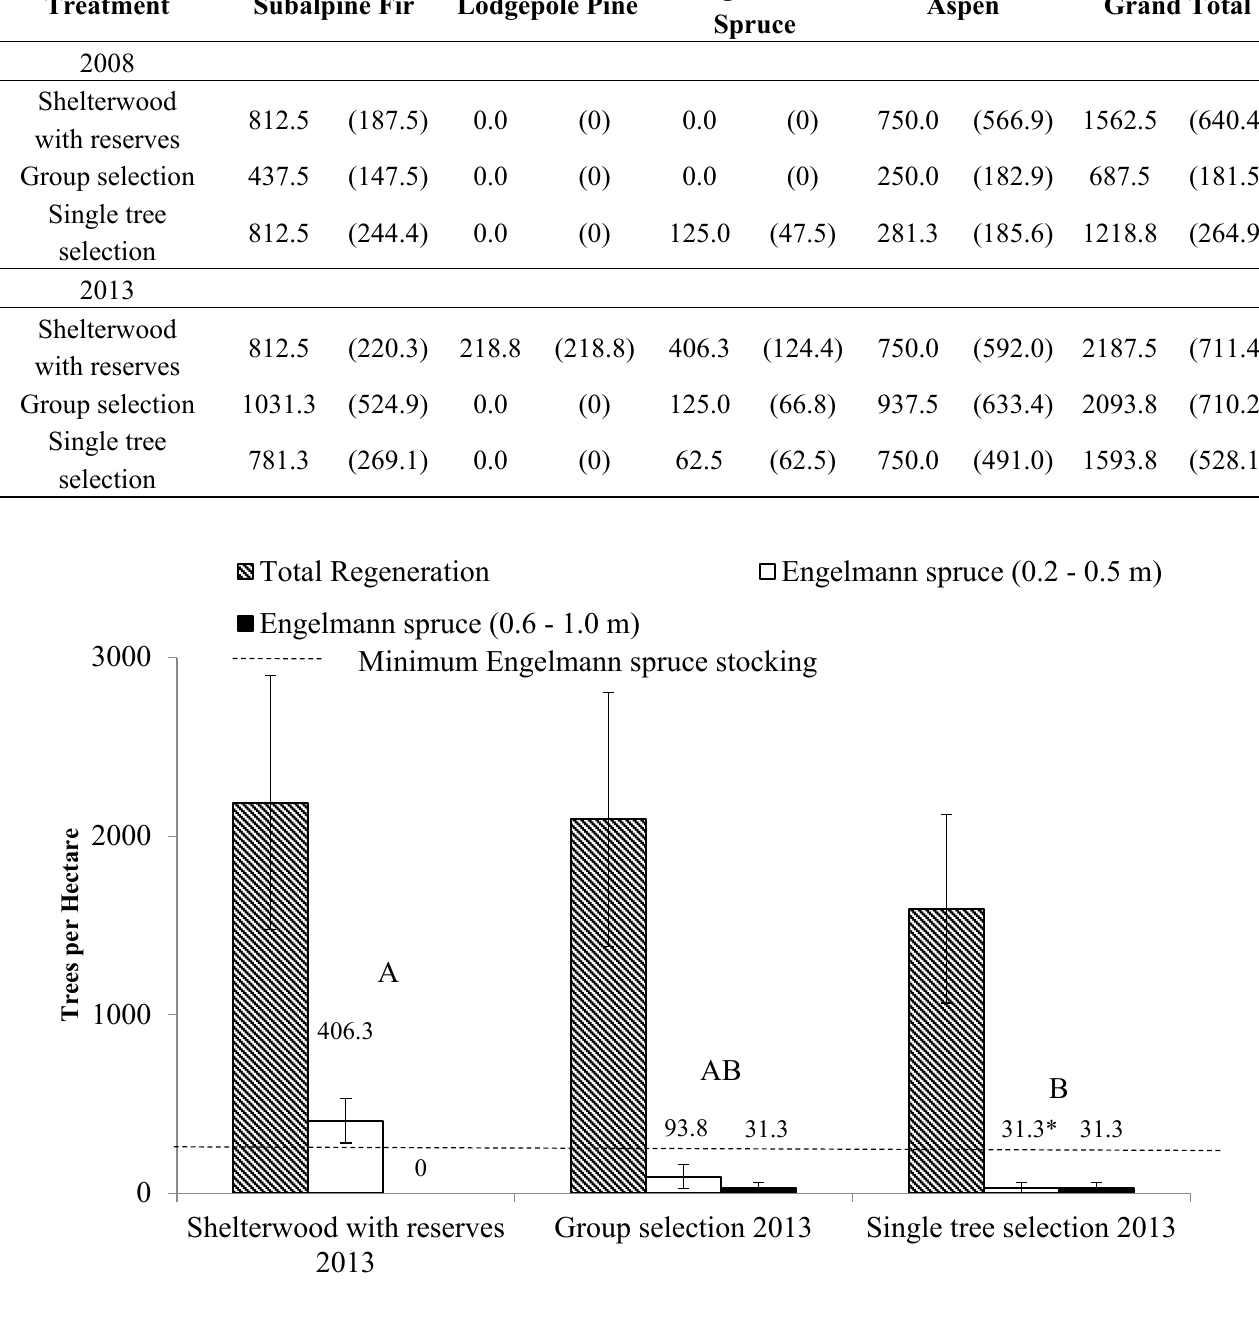
Figure 5. One-factor ANOVA for total tree regeneration and Engelmann spruce regeneration. The bars represent the standard errors. There were no significant differences between treatments for total density. Letters represent significant differences between treatments for total density of all size classes of Engelmann spruce trees per hectare (see Table 4 for total). * Engelmann spruce height was not recorded in 2013. Prior height measurement in 2008 was less than 0.5